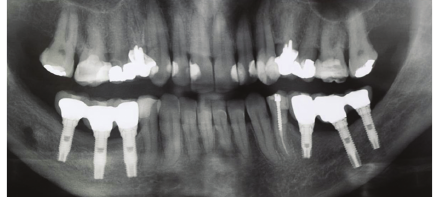
Figure 23: Panoramic X-rays after prosthetic rehabilitation.